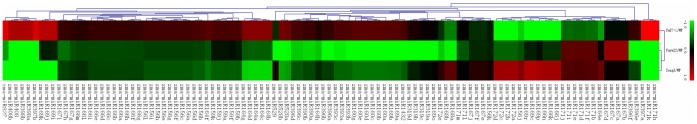
Clustering of differentially expressed microRNAs.The expression amounts derived from deep-sequencing were compared with MP (middle parental values). Green indicates down-regulation and red indicates up-regulation.